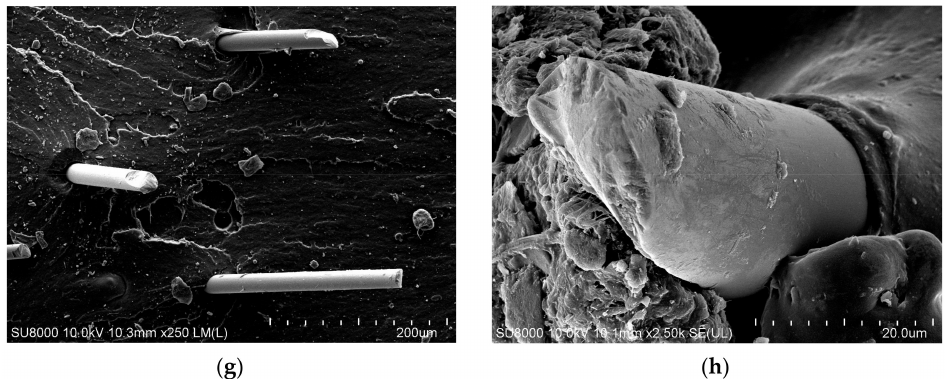
Figure 12. Electron micrographs of adhesion between BF9 and rubber matrix under different treat- ment conditions: ( a – c , e ) are the images of fiber-reinforced composite without KH560 treatment, ( d , f – h ) are the images of fiber-reinforced composite without KH560